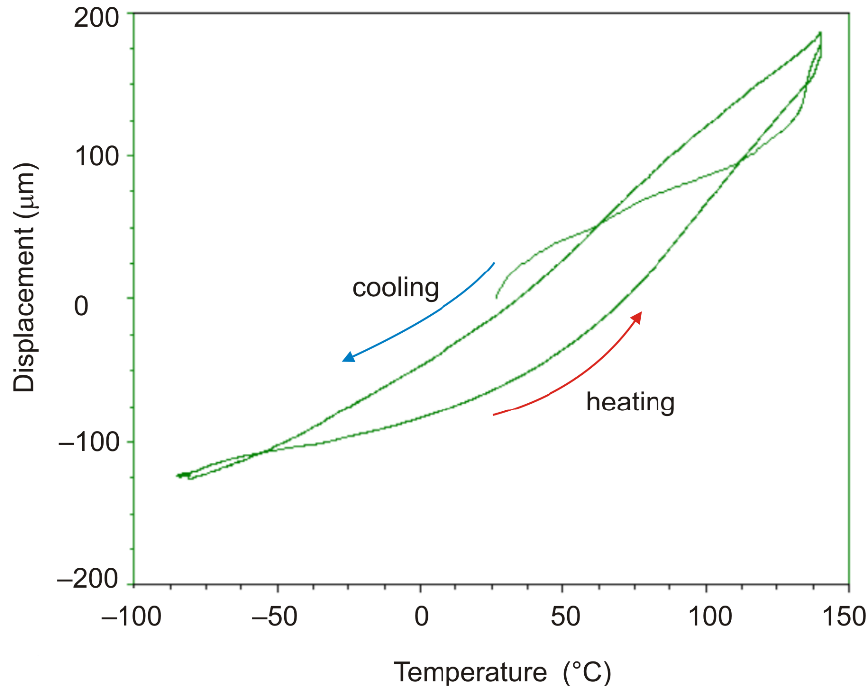
Figure 3. Characteristic temperature dependence of displacement, DeSolite DS-2015 polymer, cooling and subsequent heating rate 2 °C/min. Specimen size is 13.461 mm × 6.2 mm × 0.045 mm.